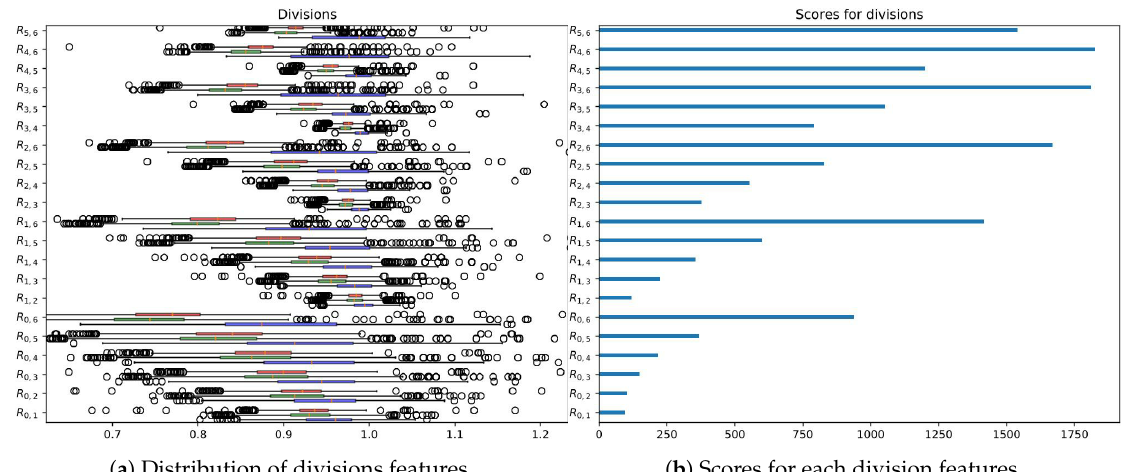
Figure 7. Analysis of divisions